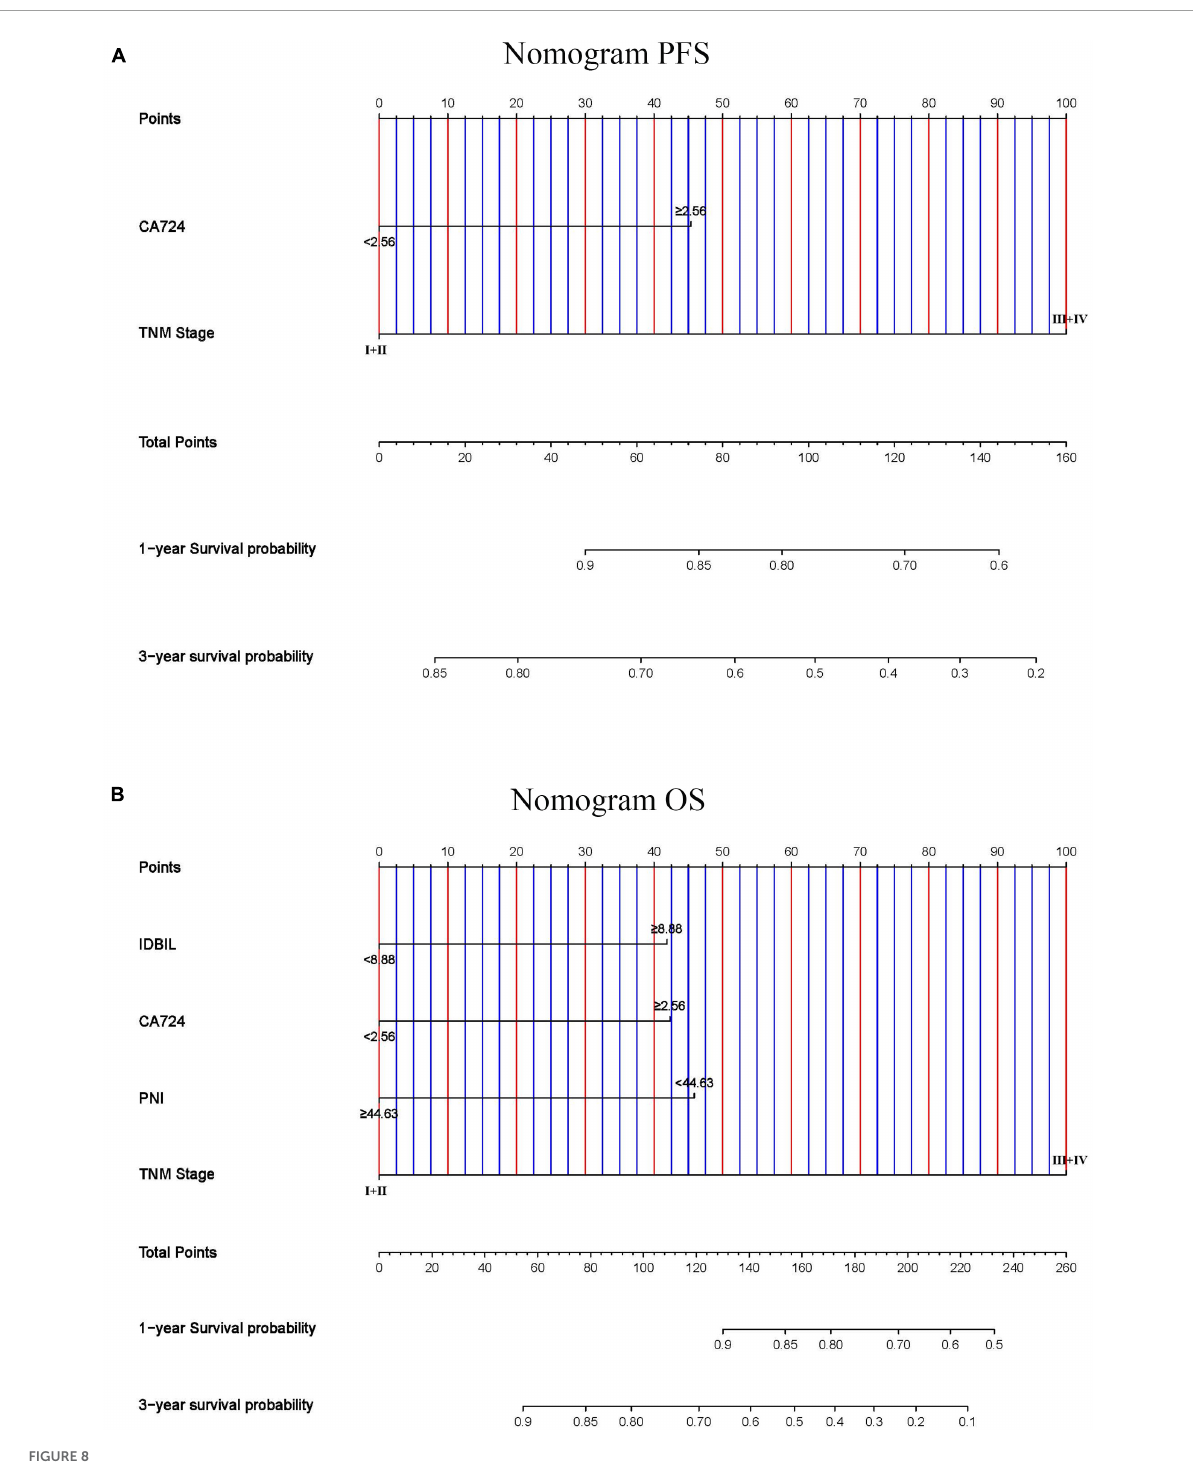
group and chemotherapy group in subgroup analysis, especially the ICIs group. In the multivariate analysis, we found that ALB, PALB, PNI, CA724, and TNM stage were significant